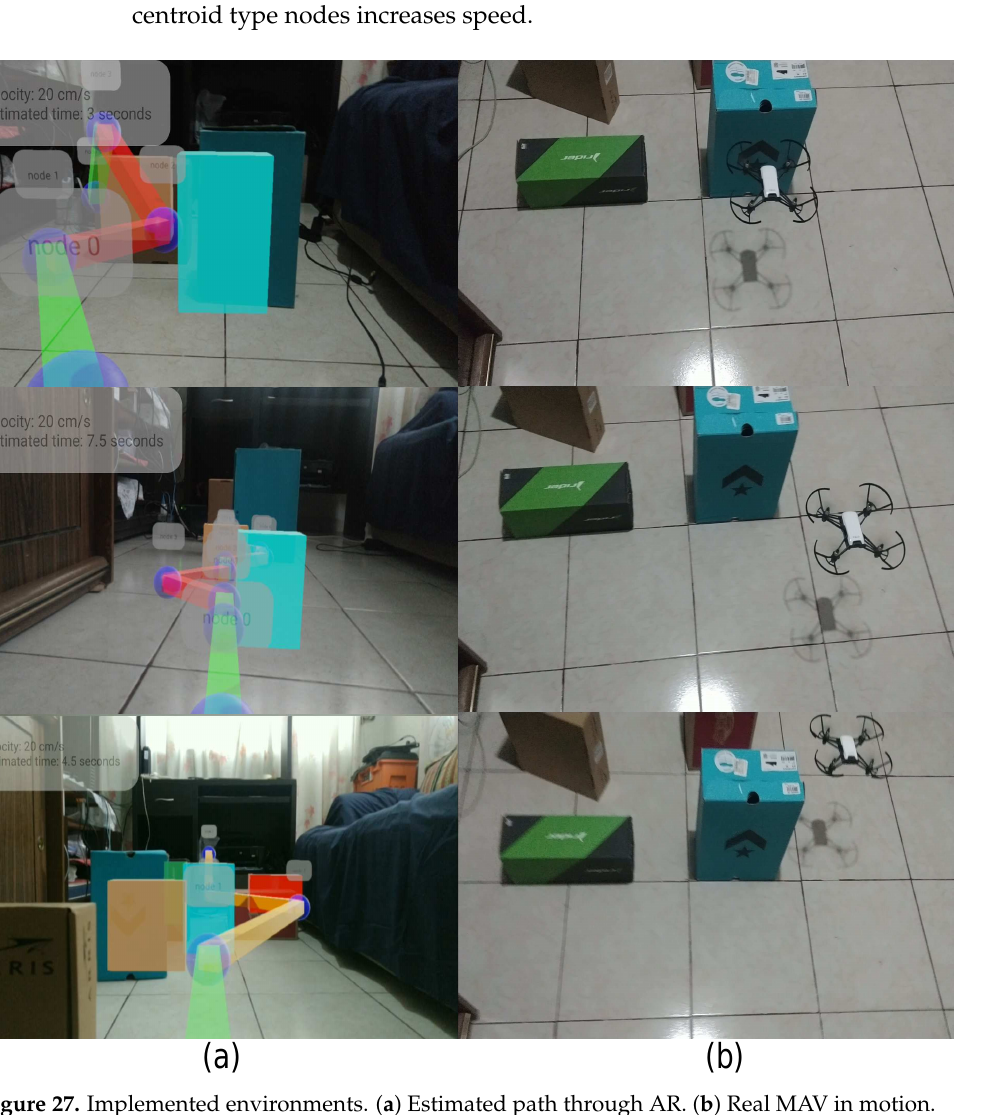
Figure 27. Implemented environments. ( a ) Estimated path through AR. ( b ) Real MAV in